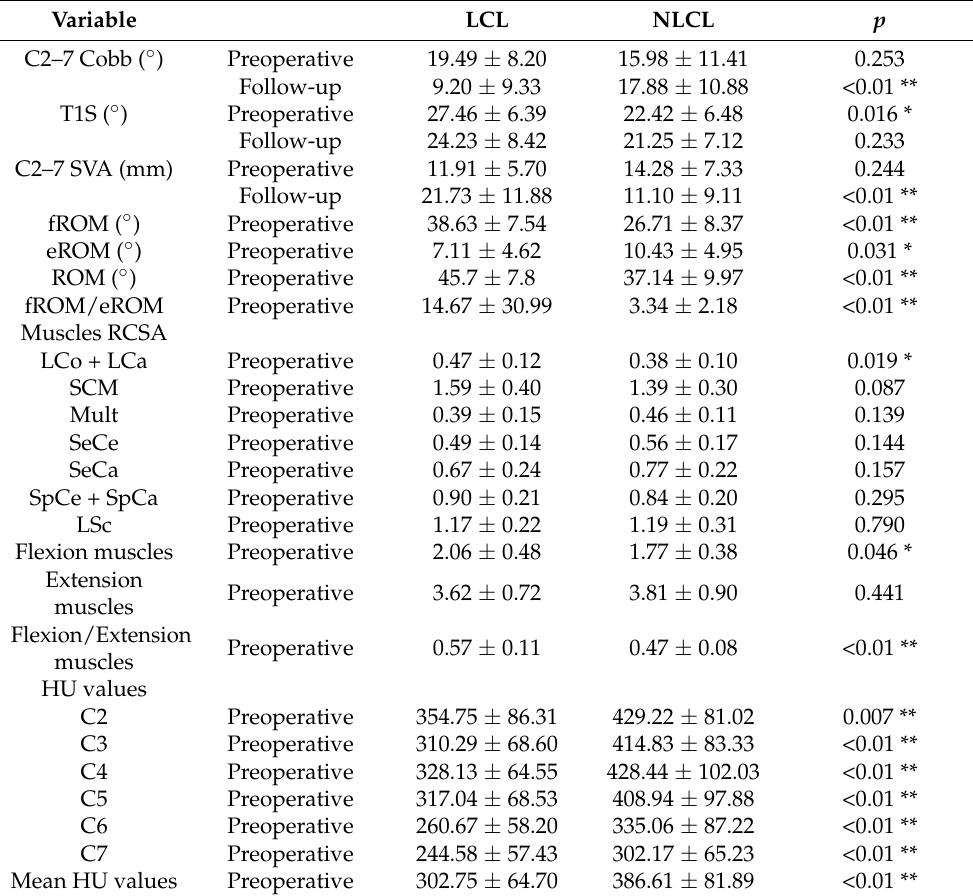
Table 3. Comparation of radiographic parameters between LCL and NLCL